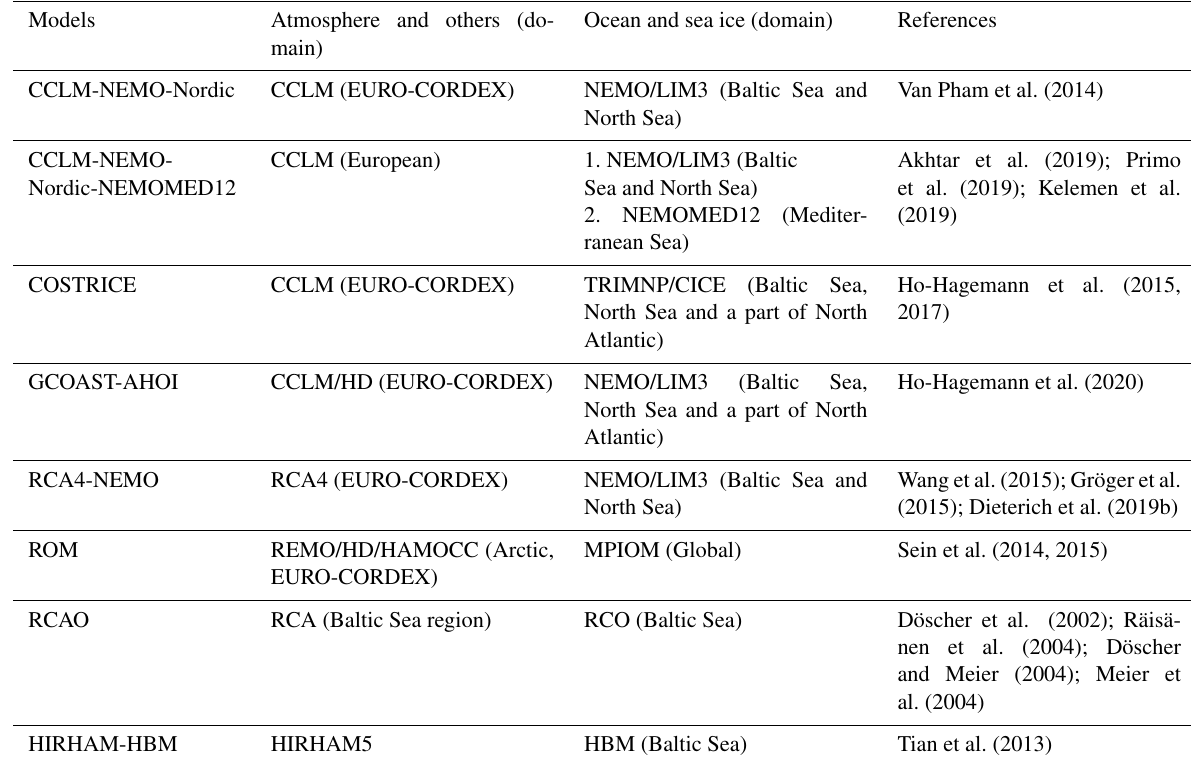
Table 1. Regional coupled climate models and their air–sea coupling domains.